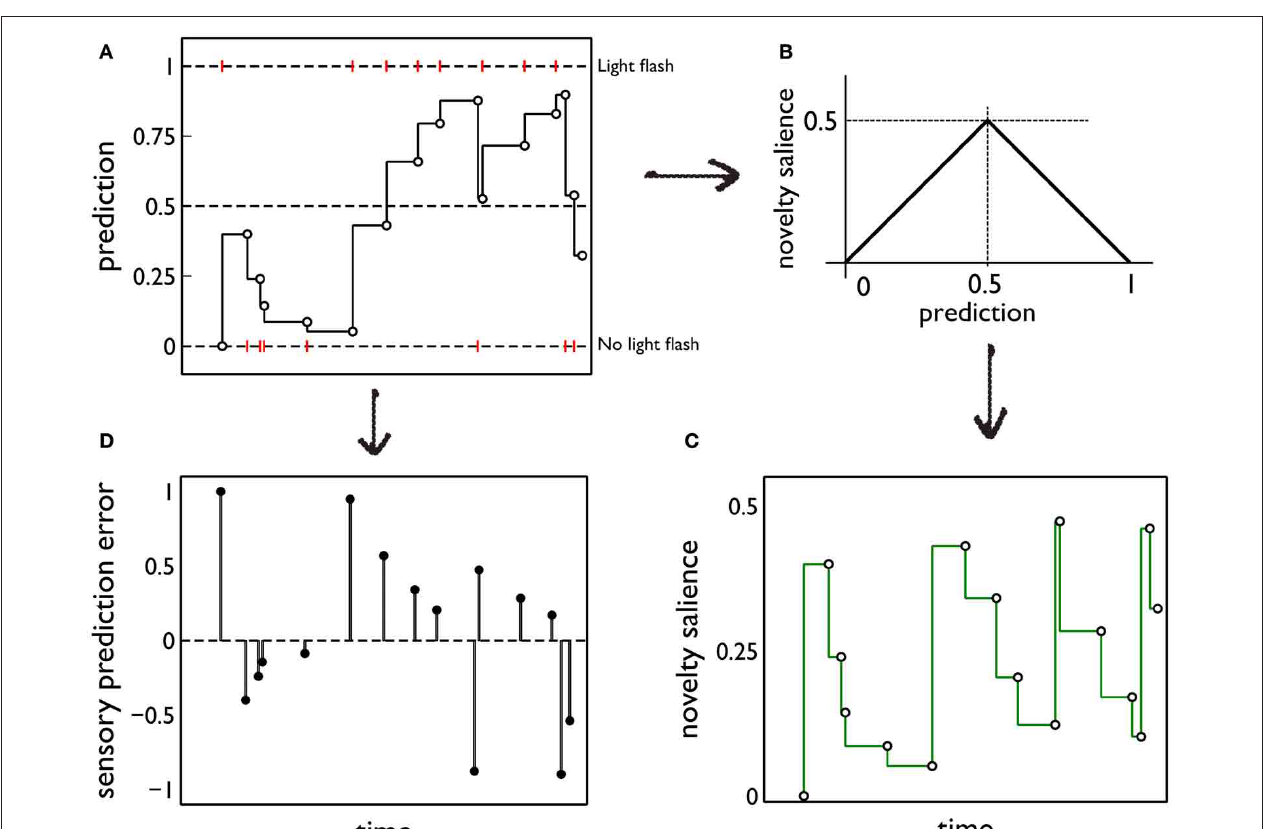
corresponding to the prediction in (A) , obtained via the mapping in (B) . Open circles represent the salience perceived at each block interaction, when the block is in view. These bouts of block-perception are longer than the observation of the light flash, but we identify each interaction with a point-time marker for simplicity. The continuous line is a formal mapping of the latent prediction using Equation (3). (D) The sensory error signal derived from (A)